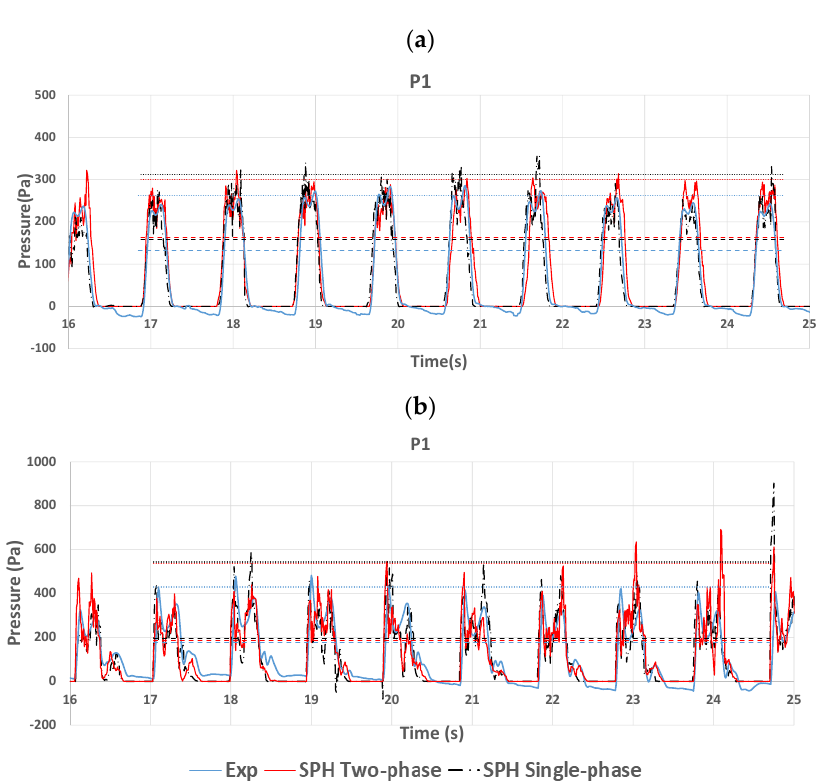
Figure 13. Comparison of pressure at P1 for ( a ) sway and ( b ) roll with a filling ratio of 25%. Table 6. Computational settings in DualSPHysics.